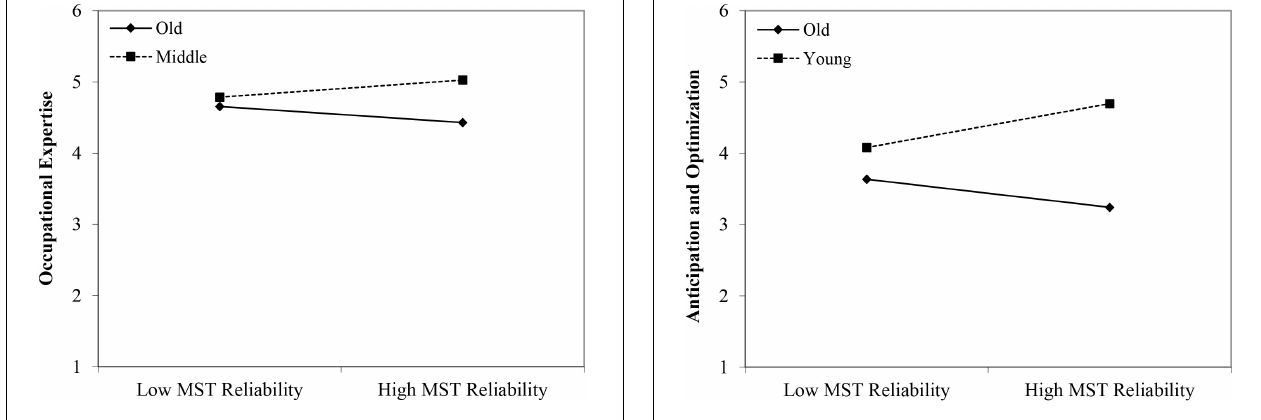
FIGURE 5 | Interaction between perceived age-based (meta-)stereotyping reliability and age groups: Predicting anticipation and optimization. Low = –1 SD , High = + 1 SD , MST = perceived age-based (meta-)stereotyping, old = older workers, young = younger workers.